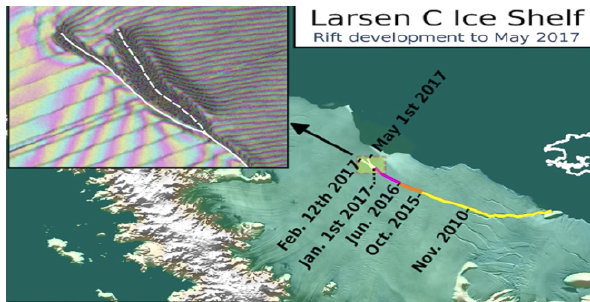
Figure A2. The Larsen C crack development (new branch) as of 1 May 2017. Labels highlight significant jumps, and the tip po- sitions are derived from Landsat (USGS) and Sentinel-1 InSAR (ESA) data. The background image blends Bedmap2 elevation (BAS) with a MODIS MOA2009 Image Map (NSIDC). Other data are from the Scientific Committee on Antarctic Research Antarctic Digital Database (SCAR ADD) and OpenStreetMap (OSM). Credit: Project MIDAS (Impact of Melt on Ice Shelf Dynamics And Stabil- ity); Adrian John Luckman, Swansea